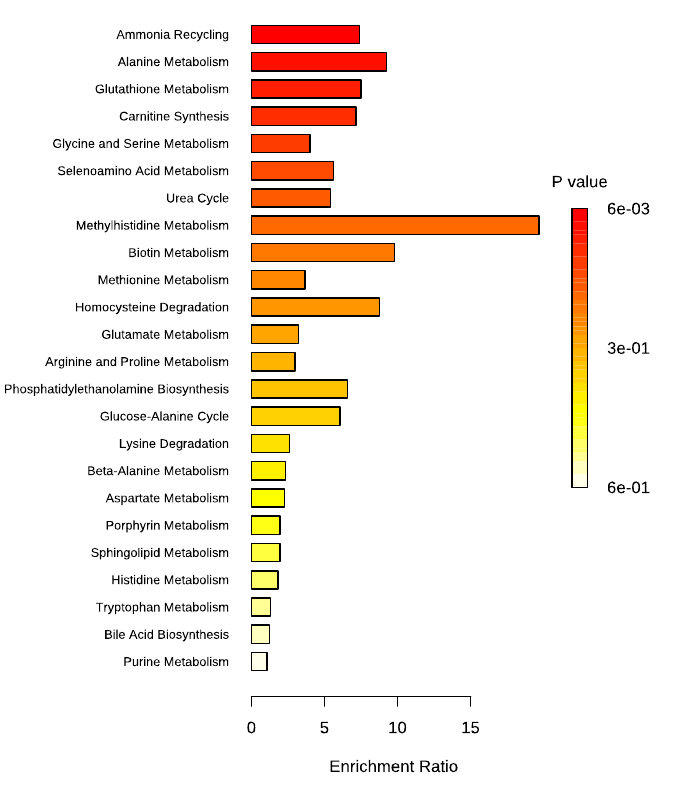
Figure 5. Metabolite set enrichment analysis (MSEA) of obesity. The horizontal bar graph summa- rizes 24 metabolic pathways using metabolites that were significantly altered in dogs with